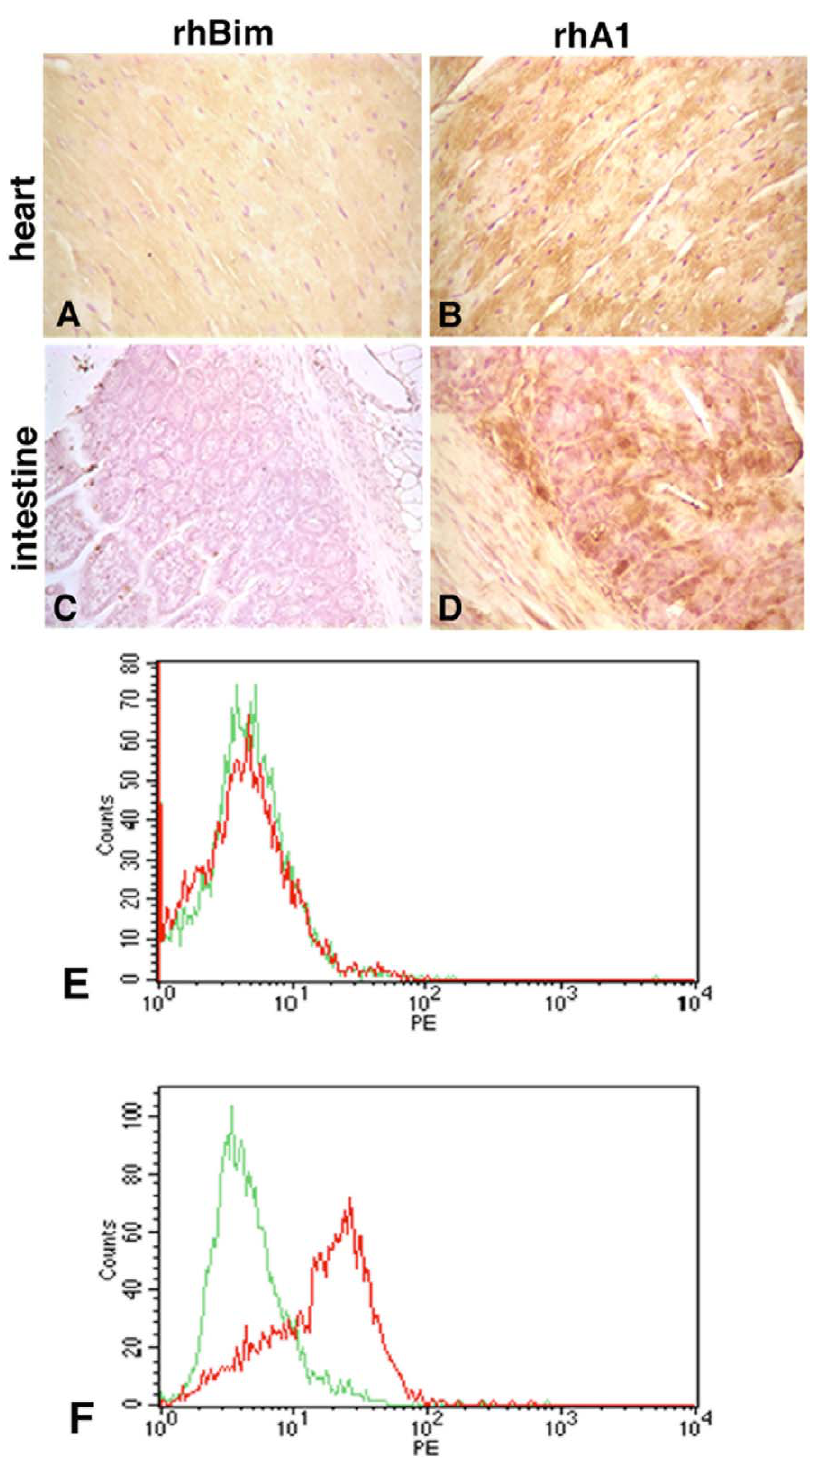
Figure 4. Treatment with rhBCL2A1 increases expression of endogenous BCL2 following CLP. Mice were treated with a single i.p. injection of 1 m g rhBim (A, C) or rhBCL2A1 (B, D) at 18 hours prior to CLP. Heart (A, B) and intestine (C, D) were examined at 24 hours following CLP. Endogenous mouse BCL2 protein was detected by immuno-staining with rabbit anti-mouse BCL2 antibody detected with 3, 3 9 -diaminobenzidine (brown) and the nuclei were stained with hematoxylin (purple). Representative FACS analysis of endogenous BCL2 expression in cardiomyocytes from mice treated as above with rhBim (E) or rhBCL2A1 (F). Green line represents isotype control and red line represents anti-mouse BCL2 antibody.